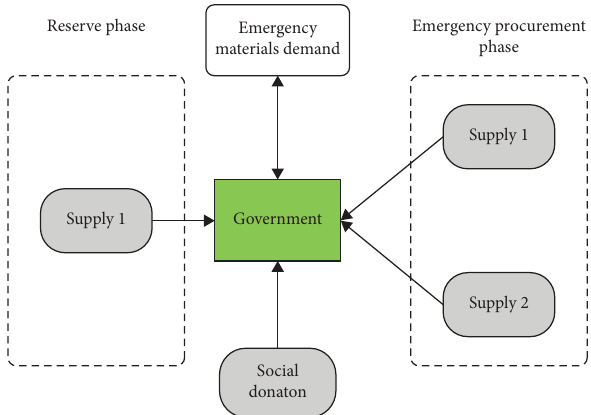
Figure 1: Pictorial representation of the emergency